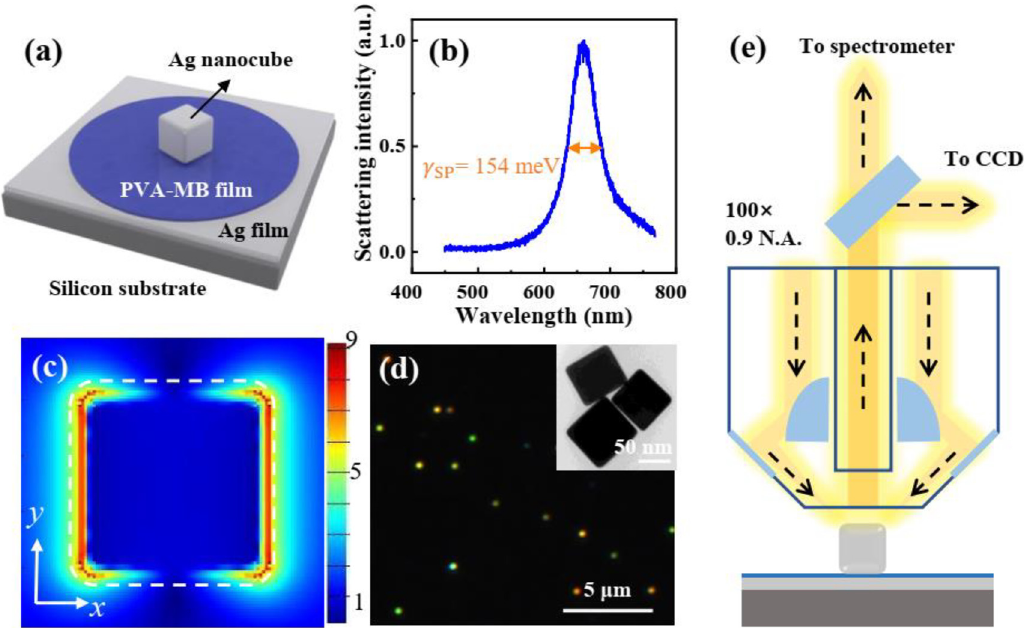
Figure 2: Optical characterization of the MB dye-Ag nanocavity. (a)Schematicrepresentationofahybridnanostructure,madeofanAgfilm,aPVAfilmdopedwithMBdyemolecules,andanAgnanocubeona siliconsubstrate.(b)NormalizedscatteringspectrumofanAgnanocavitywithoutdyemolecules.(c)Electricfielddistributionin xy planeofthe plasmonic nanocavity calculated by fi nite-difference time-domain method (FDTD). The incident light is polarized along the x -axis. White dashed lines indicate the outline of the Ag nanocube. (d) Dark- fi eld microscope image of the hybrid nanostructures. Bright spots indicate individual Ag nanocubes. Inset: TEM image of Ag nanocubes. (e) Experimental apparatus for measuring the dark- fi eld scattering signal of a single nanoparticle. The sample is obliquely irradiated by the white light and the vertical scattering signal is collected by a BD